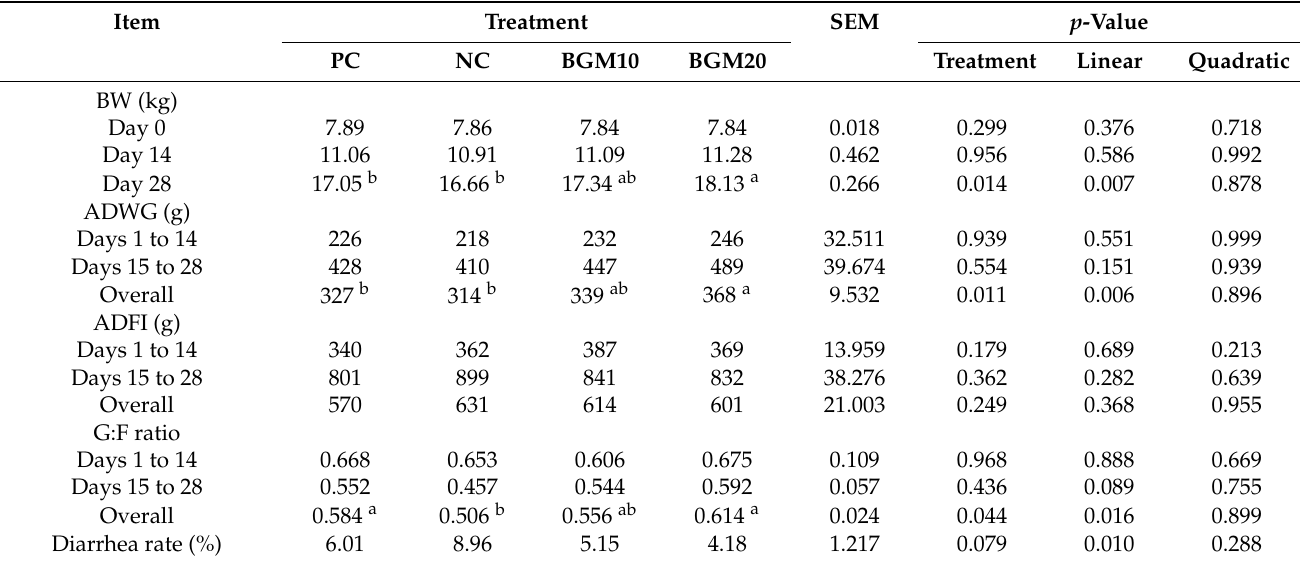
Table 2. Effect of dietary BGM with multienzyme addition on growth performance in weaning pigs 1,2 .